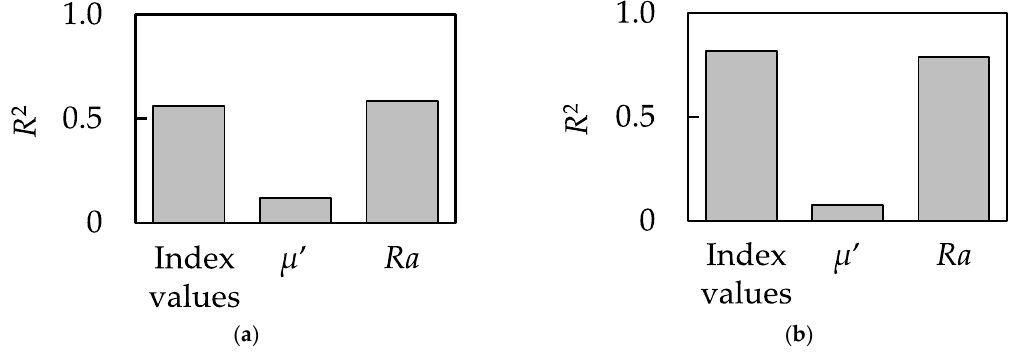
Figure 7. Comparison of the results of regression analyses for ( a ) Soft scores and ( b ) Rough scores using the index values, µ ’ and Ra .